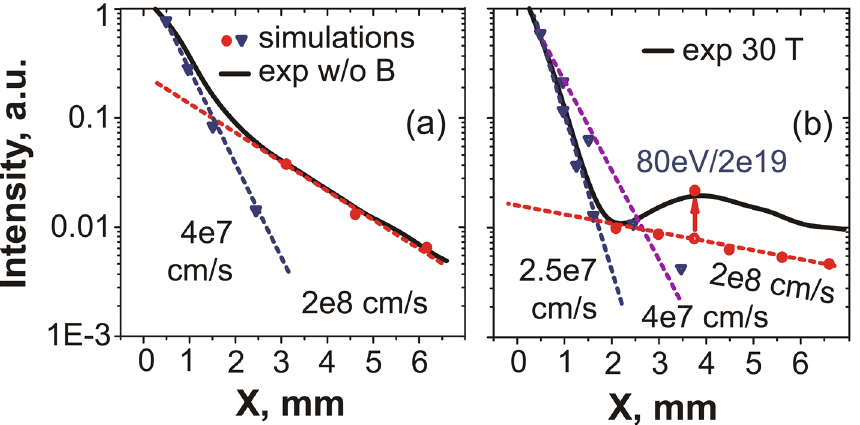
Figure 4. ( a ) Experimental (full) and simulated (dashed) spatial profiles of the X-ray resonance line Ly α in the free expansion case. The theoretical intensities were normalized by the corresponding experimental points. 30 T is applied. In the simulations, the excitation ( b ) Same in the case where a transverse magnetic field B = processes, as well as the recombination ones, were taken into account, as detailed in the “Methods” section. Note that the modelling, for the same velocity of the plasma component, but different densities can result in different slopes for the spectral